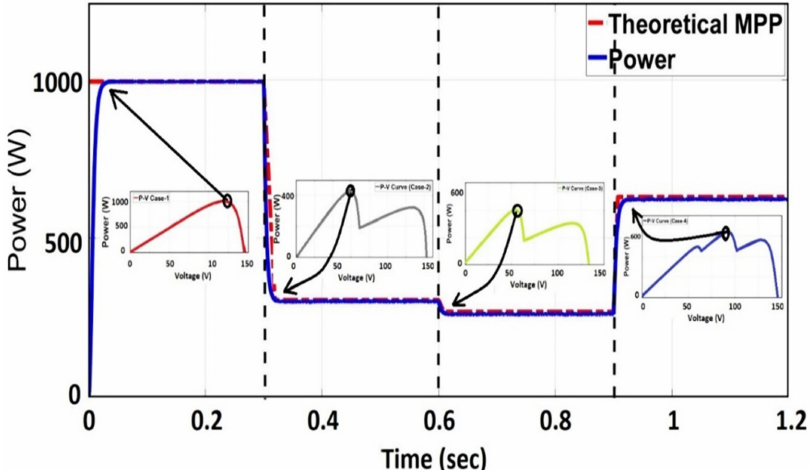
Figure 45. FA-MPPT graph for varying Irradiance and temperature.